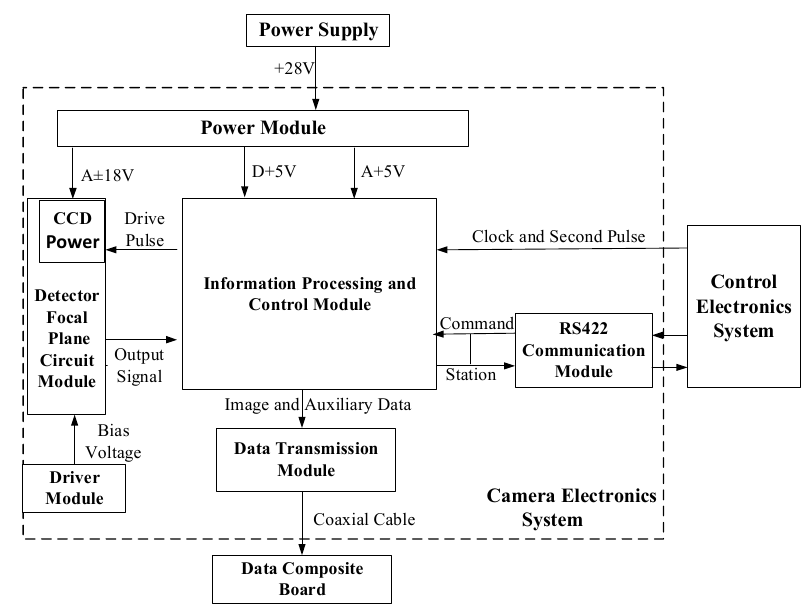
Figure 4. Electronic system block diagram.